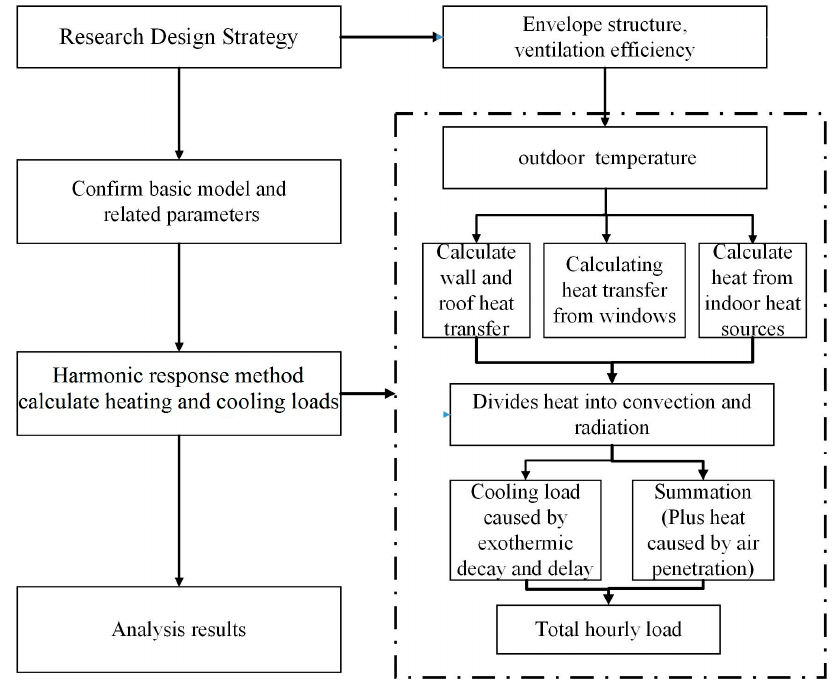
Figure 3. Schematic investigation strategy in simulation processes.